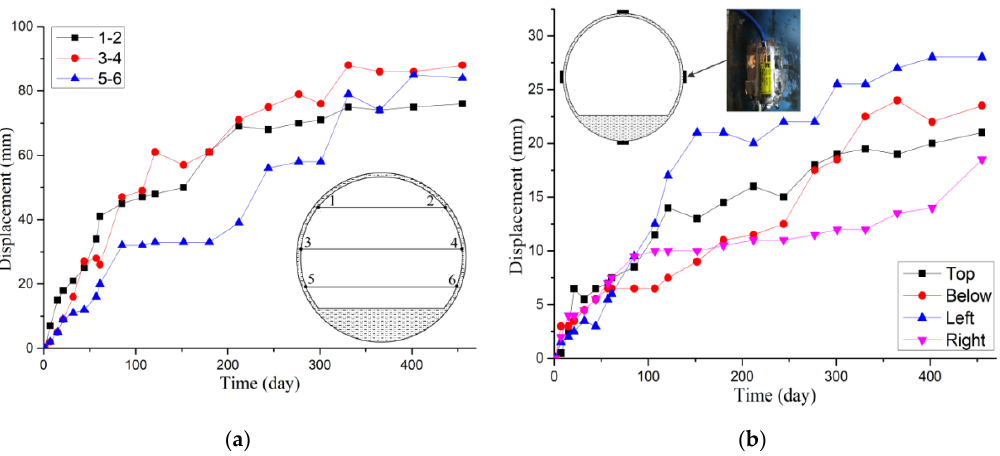
Figure 22. Results of the site monitoring: ( a ) Curves of convergent deformation, ( b ) Displacement curves of CFST.